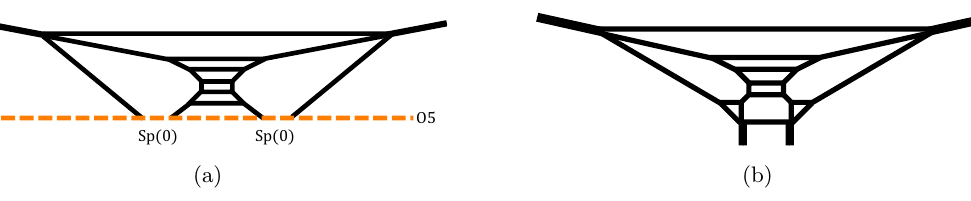
Figure 4 . (a) A 5-brane diagram for the SO(12) gauge theory with a massless hypermultiplet in the conjugate spinor representation. (b) A 5-brane diagram for an SU(6) gauge theory with a massless hypermultiplet in the rank-3 antisymmetric representation, obtained by applying generalized (cid:13)op transitions and decoupling to the diagram in (cid:12)gure 4(a). It will turn out that the Chern-Simons level of this theory is (cid:20) = 3 in section